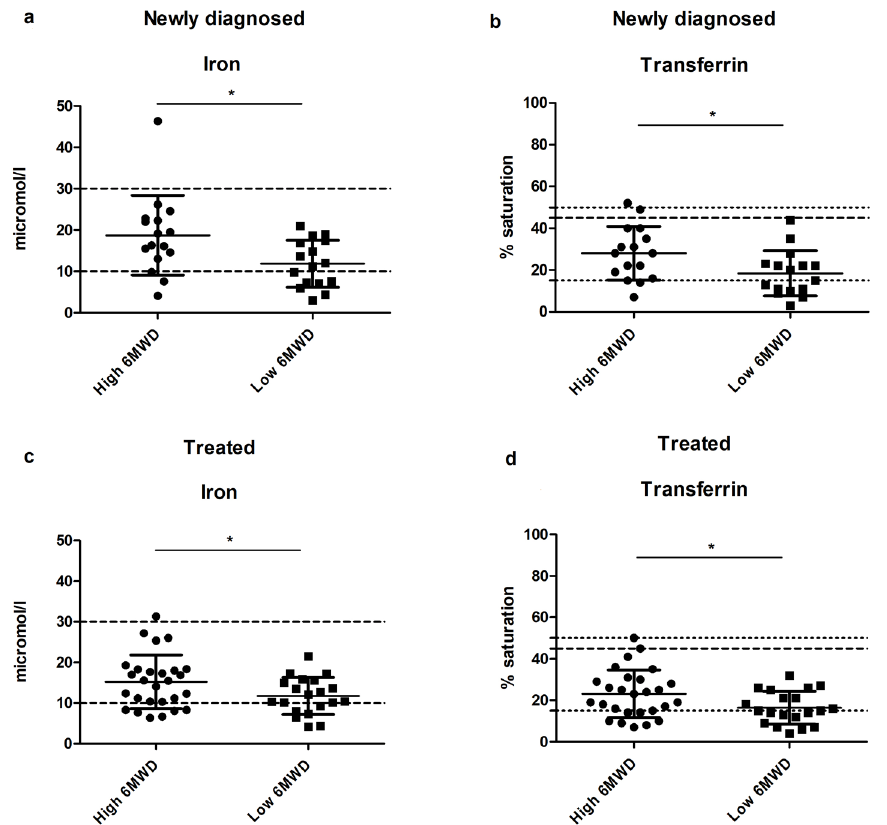
Figure 1. Iron levels and transferrin saturation in newly diagnosed and treated patients with a higher or lower 6MWD than the group mean (* p < 0.05). ( a ) Iron levels in newly diagnosed PAH and CTEPH patients with a high vs. low 6MWD. ( b ) Transferrin saturation levels in newly diagnosed PAH and CTEPH patients with a high vs. low 6MWD. ( c ) Iron levels in treated PAH and CTEPH patients with a high vs. low 6MWD. ( d ) Transferrin saturation levels in treated PAH and CTEPH patients with a high vs. low 6MWD. 6MWD: six-minute walk distance, PAH: pulmonary arterial hypertension, CTEPH: chronic thrombo-embolic pulmonary hypertension.